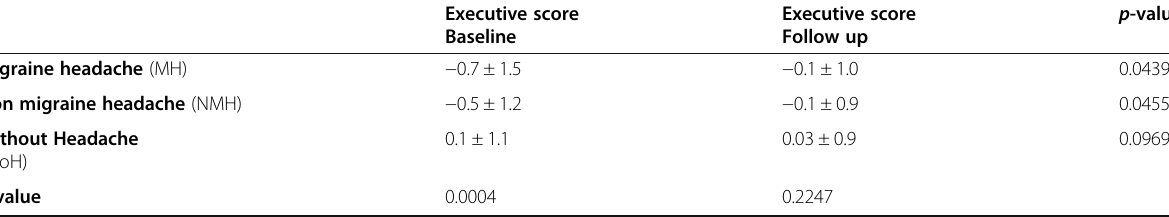
Table 3 Bivariate comparison between headache diagnosis and executive performance at baseline and at follow up Executive score